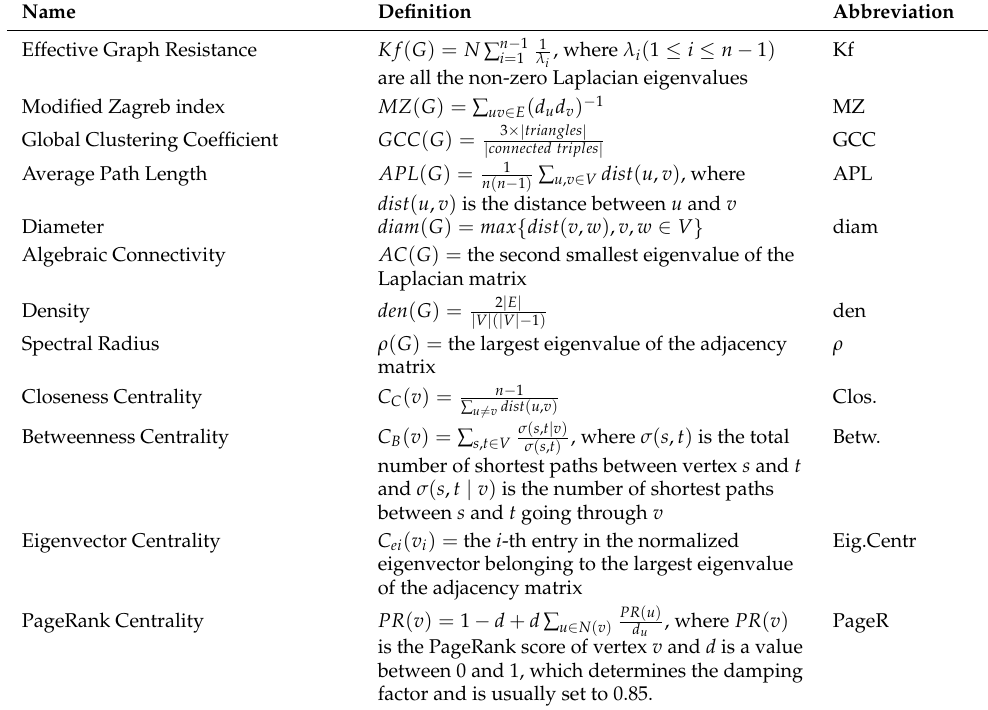
Table 1. All graph measures considered in this